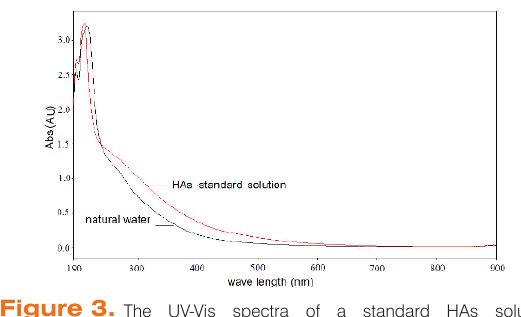
Figure 3. The UV-Vis spectra of a standard HAs solution (50 mg L -1 HAs) and a natural water sample (25 mg L -1 HAs).